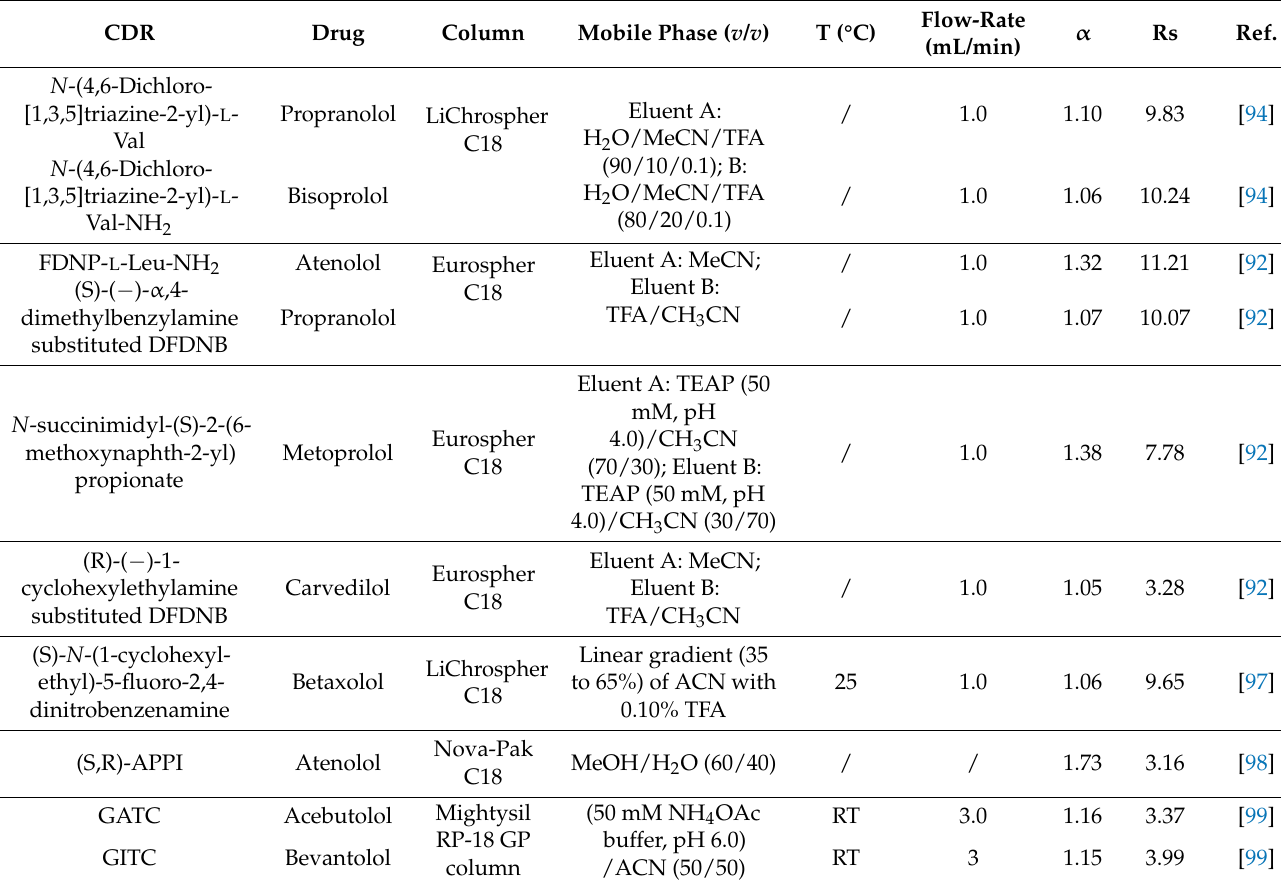
Table 11. Typical results for the enantioseparation of β -blockers involving